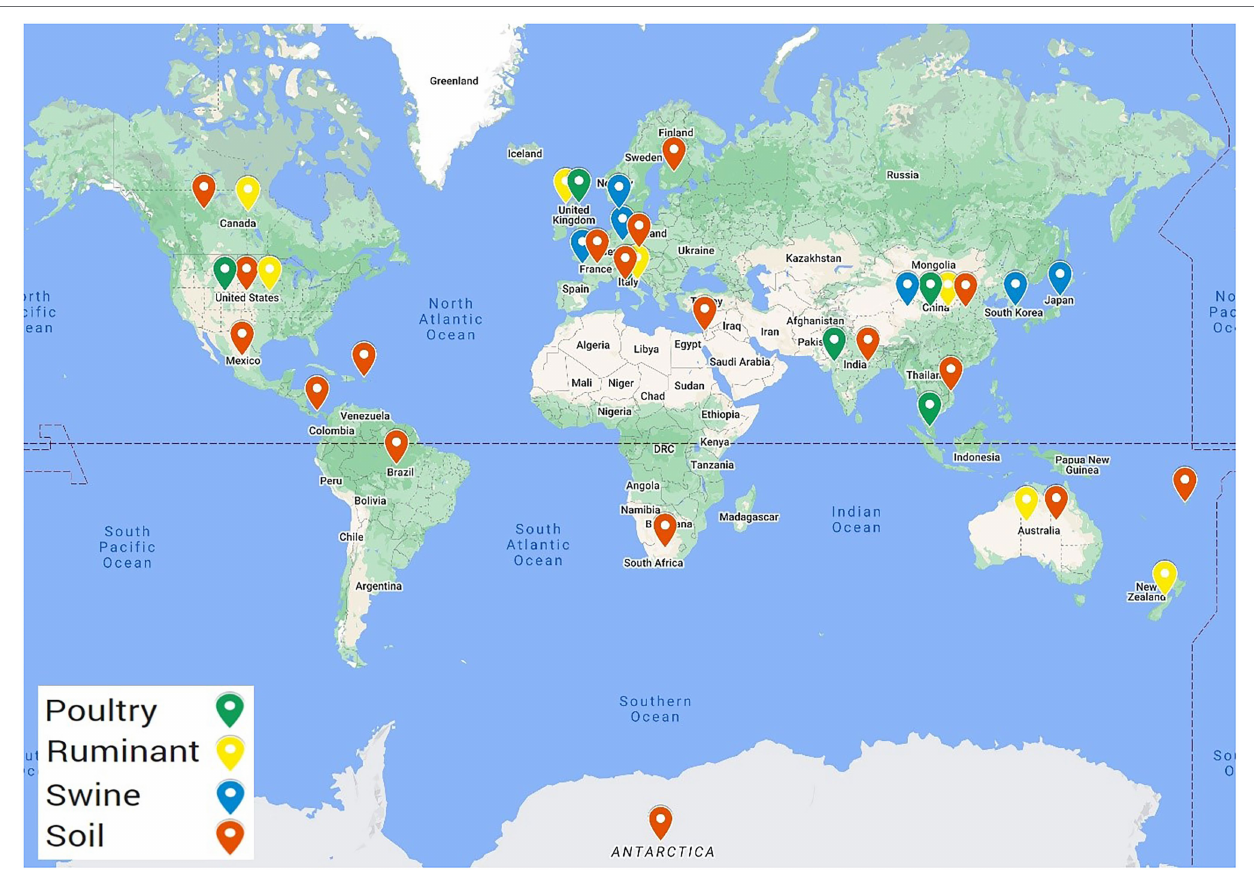
FIGURE 1 | Geographical locations of the selected metagenomic samples containing ARGs. Metagenomes selected from NCBI SRA including 509 ruminant metagenomes from eight different countries, 277 poultry metagenomes from six countries, 710 swine metagenomes sourced from seven countries, and soil metagenomes from 23